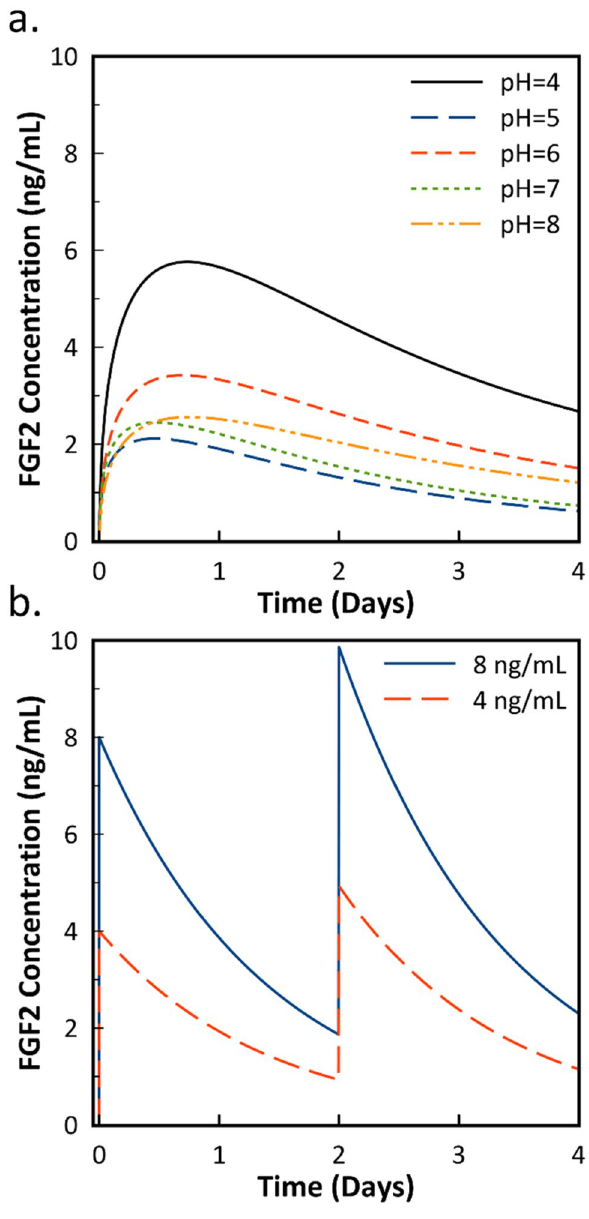
Figure 4. ( a ) Modeled concentration of FGF2 released from PEMs. pH values refer to PEM assembly conditions. Model assumes a 1.9 cm 2 surface area and 600 μL of media. ( b ) Modeled FGF2 concentrations assuming exogenous supplementation of FGF2 at 4 ng/mL, and 8 ng/mL, at both t = 0 and t = 2 days. Both figures assume FGF2 degradation based on an ELISA-detectable half-life of 22.75